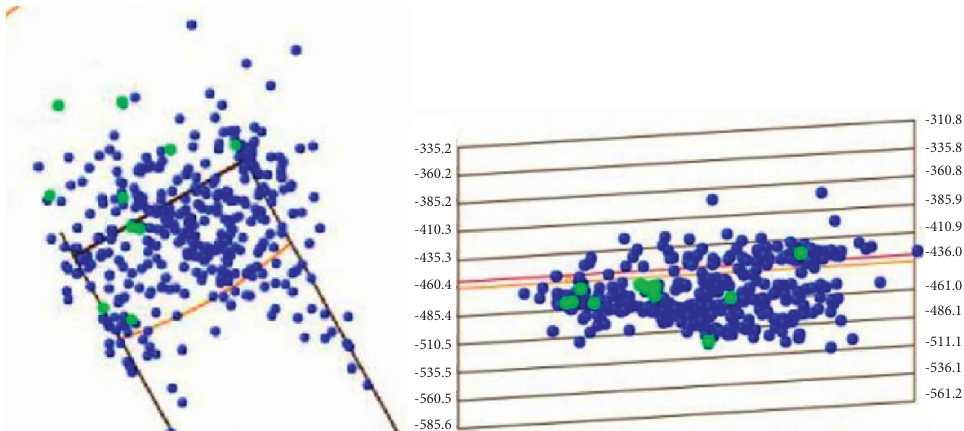
Figure 6: Plan and profile of the 16001 working face microseismic event distribution in the initial mining stage.